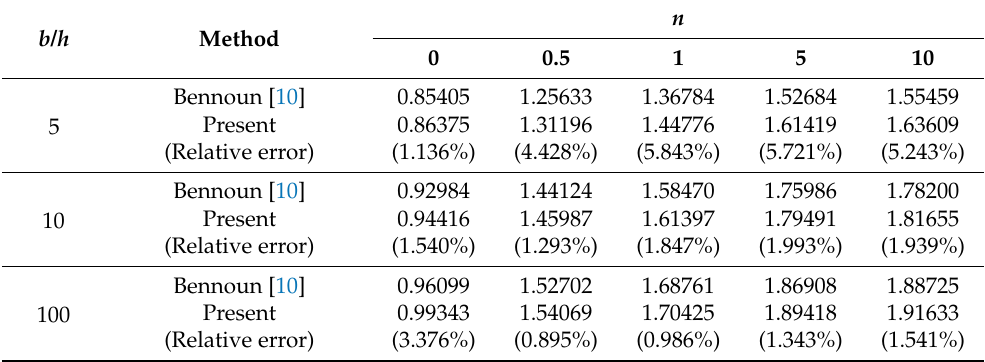
Figure 5. Variation of the calibrated fundamental frequency, ω , with respect to the width-to-thickness ratio b / h . Table 3. Comparison of calibrated fundamental frequencies, ω , for simply supported square FG sandwich plates with homogeneous softcores